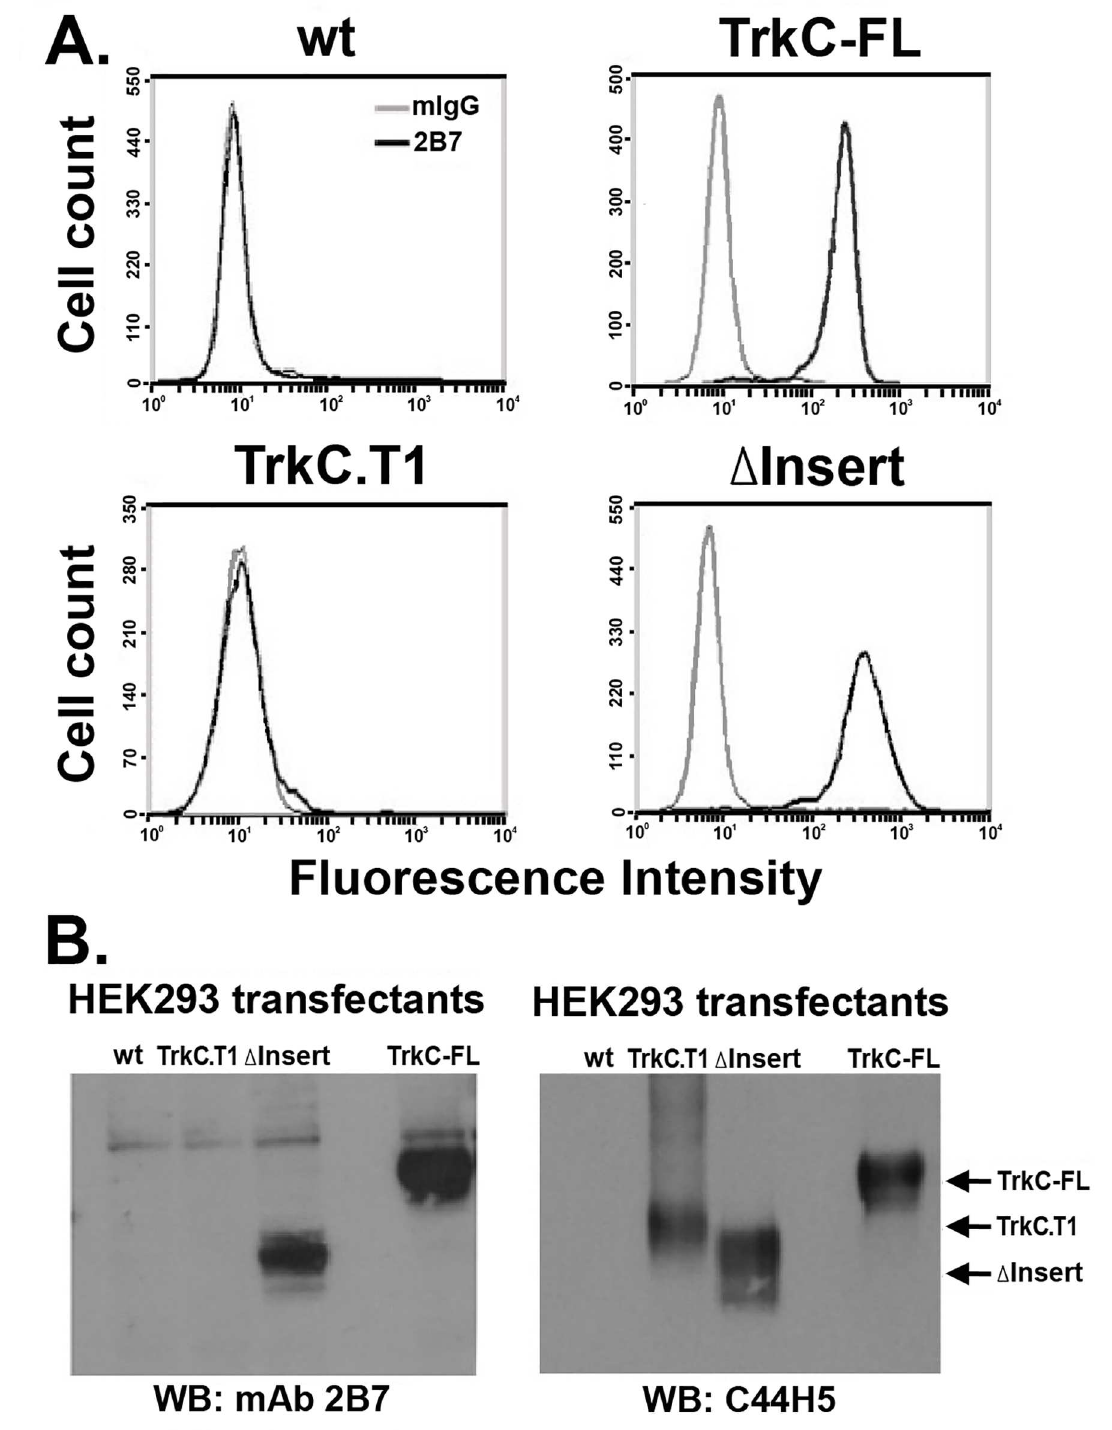
Fig 2. Deletion of the intracellular neo-epitope of TrkC.T1 affords 2B7 mAb recognition of the ectodomain. ( A ) The neo-epitope of TrkC.T1 (see Fig 1B) was deleted to generate TrkC.T1 Δ insert . TrkC-FL, TrkC.T1, and TrkC.T1 Δ insert were each transfected in HEK293 cells. After drug selectionstable transfectants or control cells were studied by FACScan binding assays using mAb 2B7. ( B ) Lysates of the same cells were studied by western blotting with mAb 2B7 or with mAb C44H5 (total